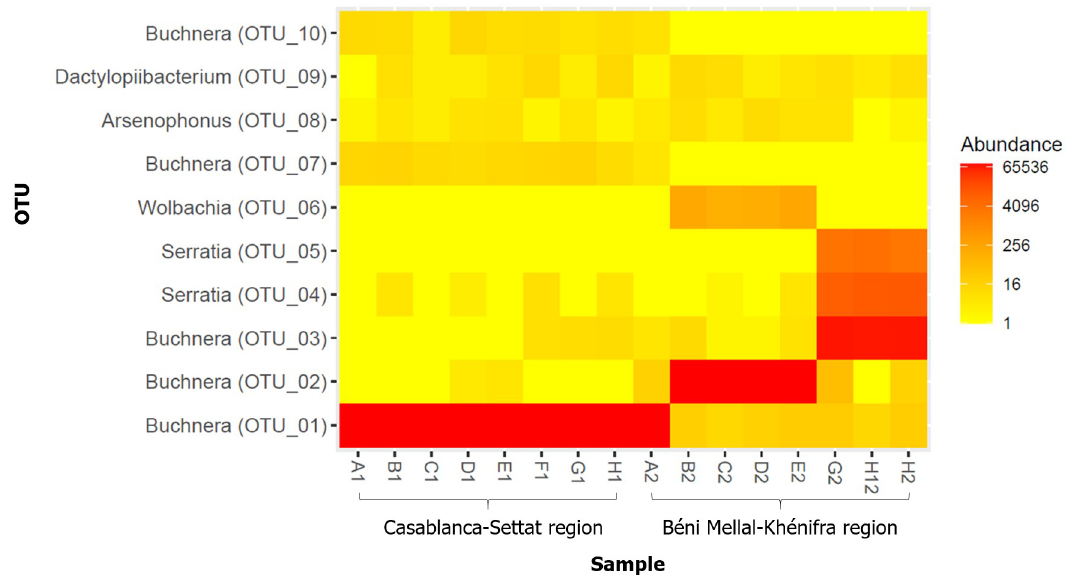
Fig 2. Relative abundance of bacterial taxa from Illumina sequencing of 16S rRNA amplicons, represented as a heat map based on the log-transformed values. The warm colors indicating higher and cold colors indicating lower abundance. Each color bar corresponding to one sampled